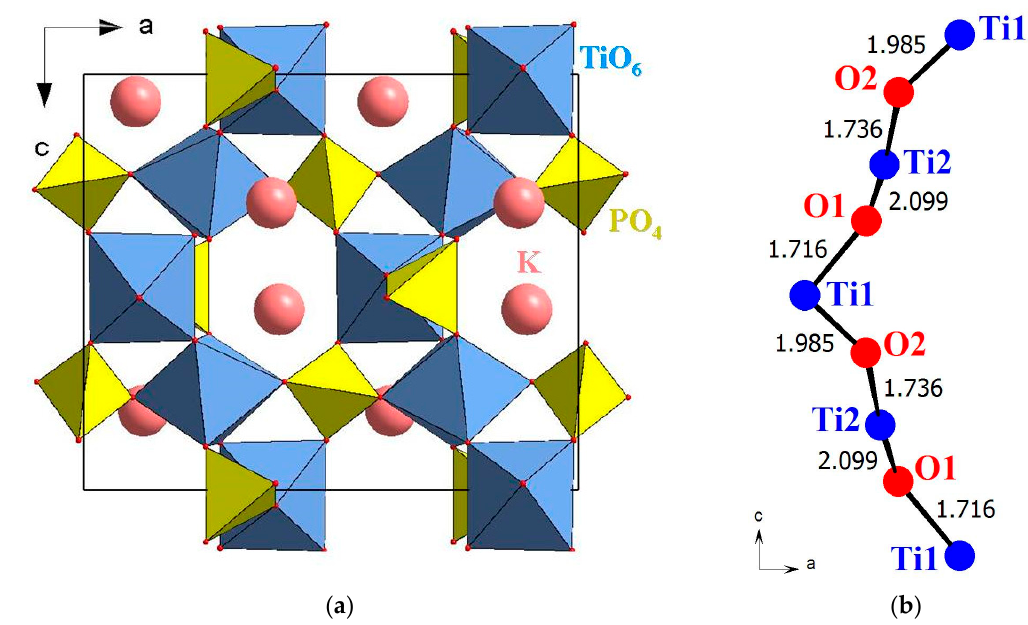
Figure 1. ( a ) Projection of the KTiOPO 4 structure onto the (101) plane. ( b ) Alternation of Ti–O bond lengths (Å) in chains of TiO 6 octahedra in the KTP structure: the O1 and O2 atoms occupy cis positions in the Ti1O 6 octahedron and trans positions in the Ti2O 6 octahedron.